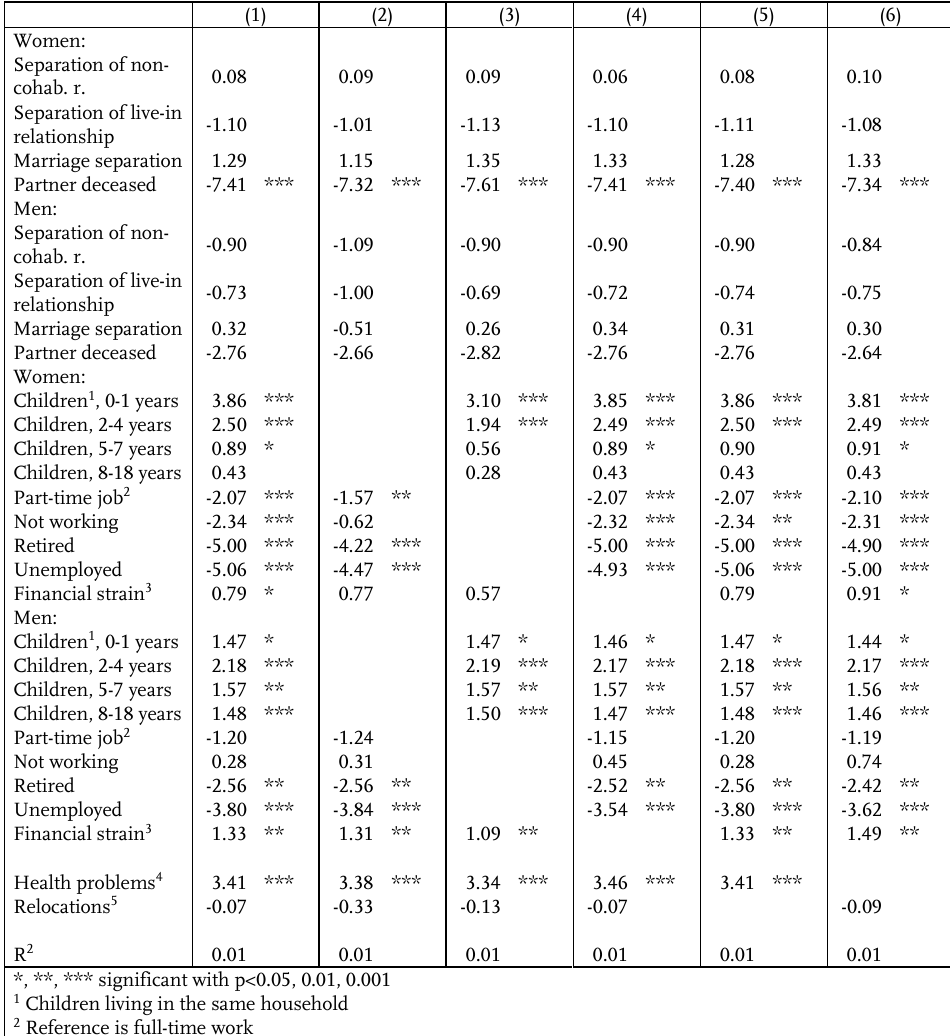
Table A.9 : Effects of relationship endings, children, employment, financial strain, relocations, and health on absence of secondary-sphere contacts (disconnectedness from friends and relatives; linear- probability models with fixed effects, percentage